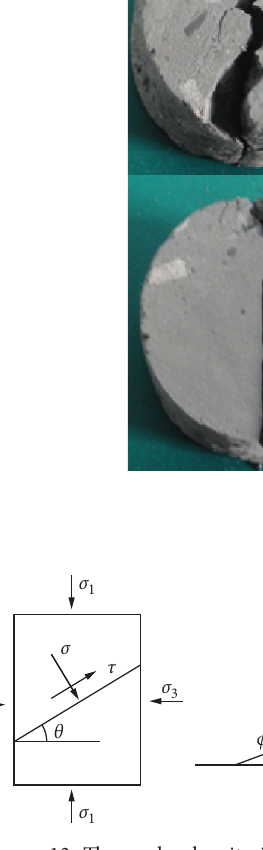
Figure 13: The coulomb criterion in σ − τ coordinates.